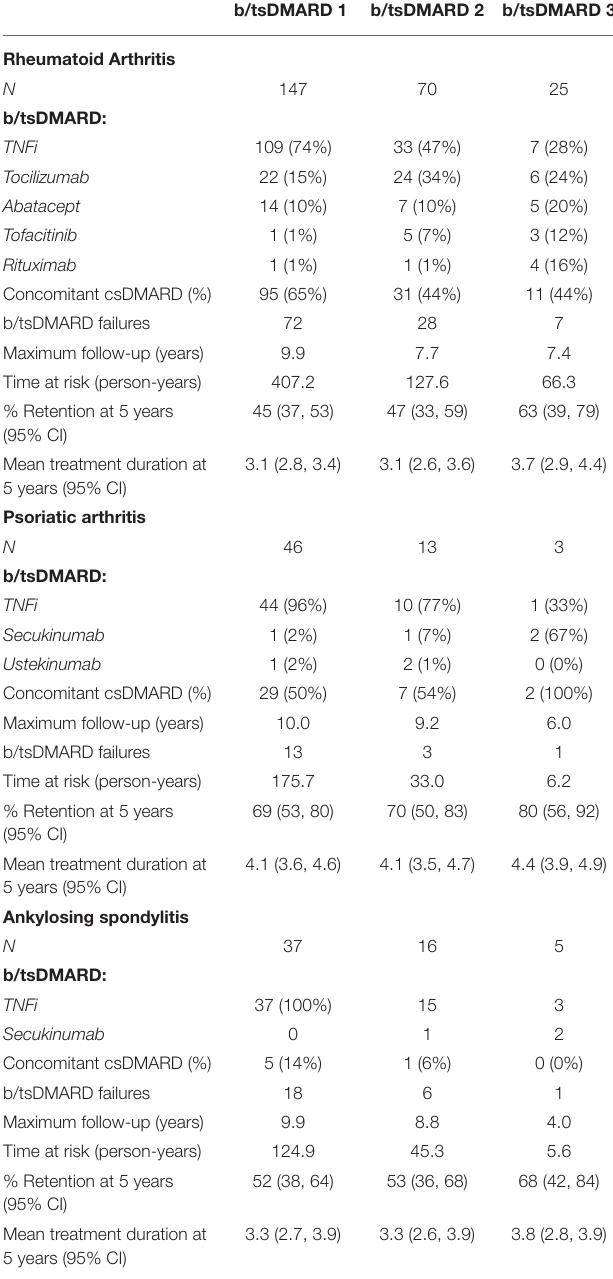
TABLE 2 | Treatments, failures, retention rates and duration for each episode of b/tsDMARD use by diagnosis